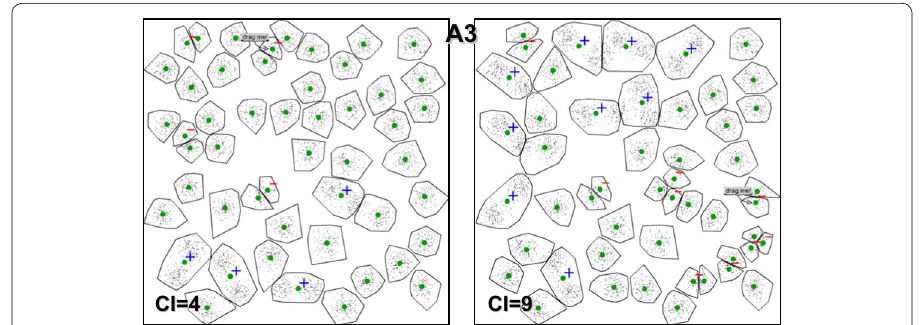
Fig. 7 Number of wrongly allocated prototypes in dataset A 3 , as measured by centroid index. Prototypes mapped more than once are marked by ‘